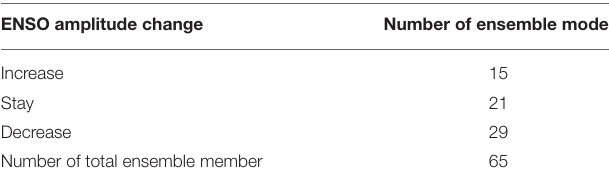
TABLE 1 | The number of ensemble members in which ENSO amplitude increases, decrease or stays the same from the present (1960–2010) to the end of 21st century (2050–2100) in 65-ensemble members. Note that ensemble member in which the changes in ENSO amplitude in the end of 21st century are within ± 10% from the present climate is considered to stay the